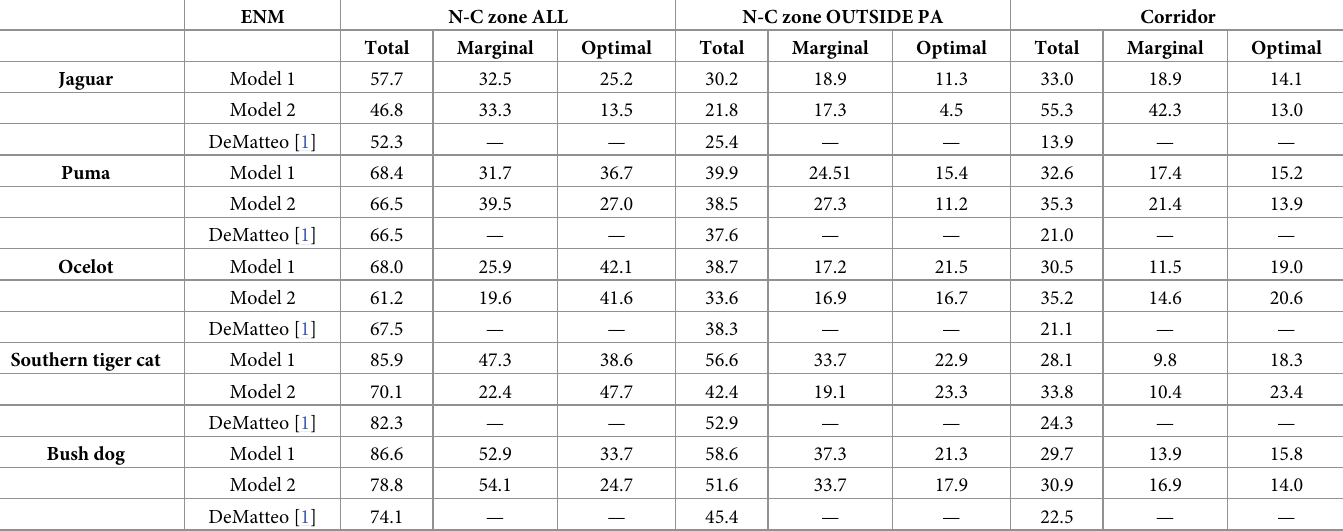
The N-C zone ALL refers to the proportion (%) of suitable habitat across the total area in the N-C zone of Misiones, including overlap with existing protected